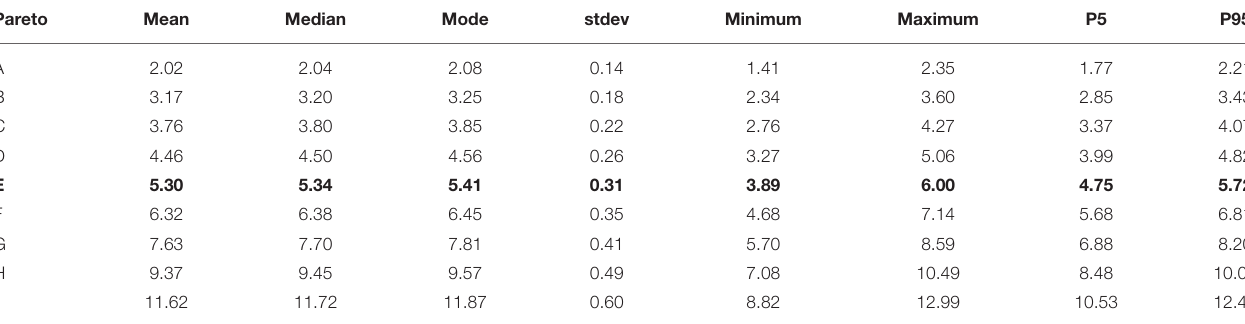
Pareto point E is the optimal point considering both the objectives.